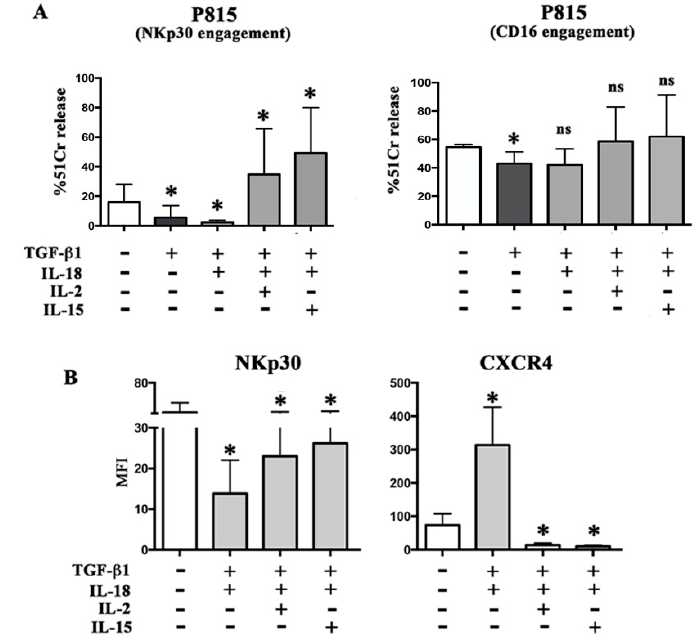
Figure 2. IL-2 or IL-15 restores receptor expression and function. PB NK, cultured for 48 h, in the absence or in the presence of the indicated cytokine combinations, were analyzed for cytolytic activity against the Fc γ R+ P815 target cell in the presence of mAb specific for NKp30 or CD16 ( 51 Cr release) (panel A ), and for the expression of NKp30 and CXCR4 (flow cytometry) (panel B ). Average of four independent experiments (four donors). Mean of MFI and 95% confidence intervals are shown. * p < 0.05; ns means p not significant. Statistical significance has been referred to cells cultured without cytokines (white bar).